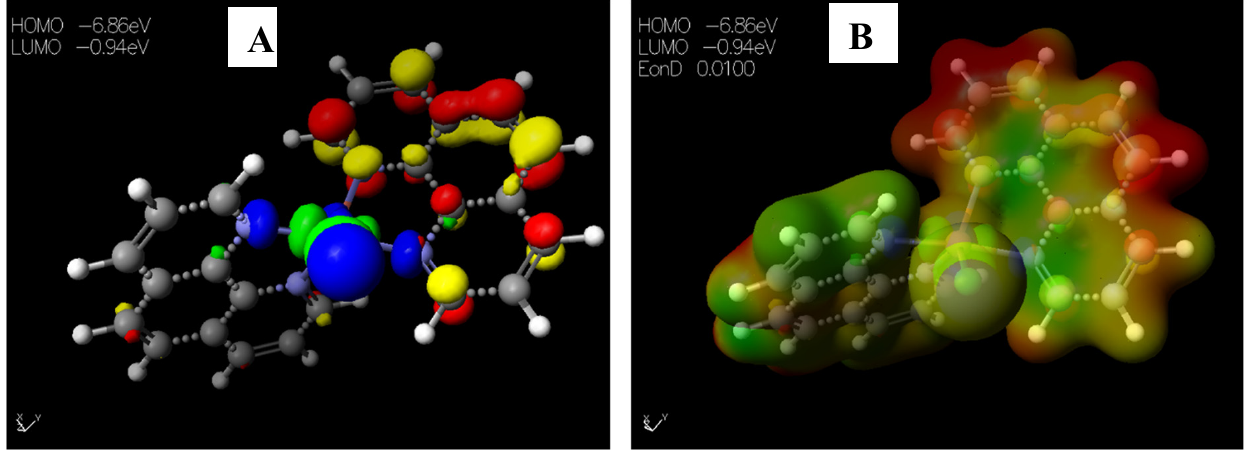
Figure 4. Images showing the ( A ) Highest occupied molecular orbital (HOMO) and Lowest unoccupied molecular orbital (LUMO) and ( B ) Molecular electrostatic potential (MESP) plots of [Cu(phen) 2 Cl].